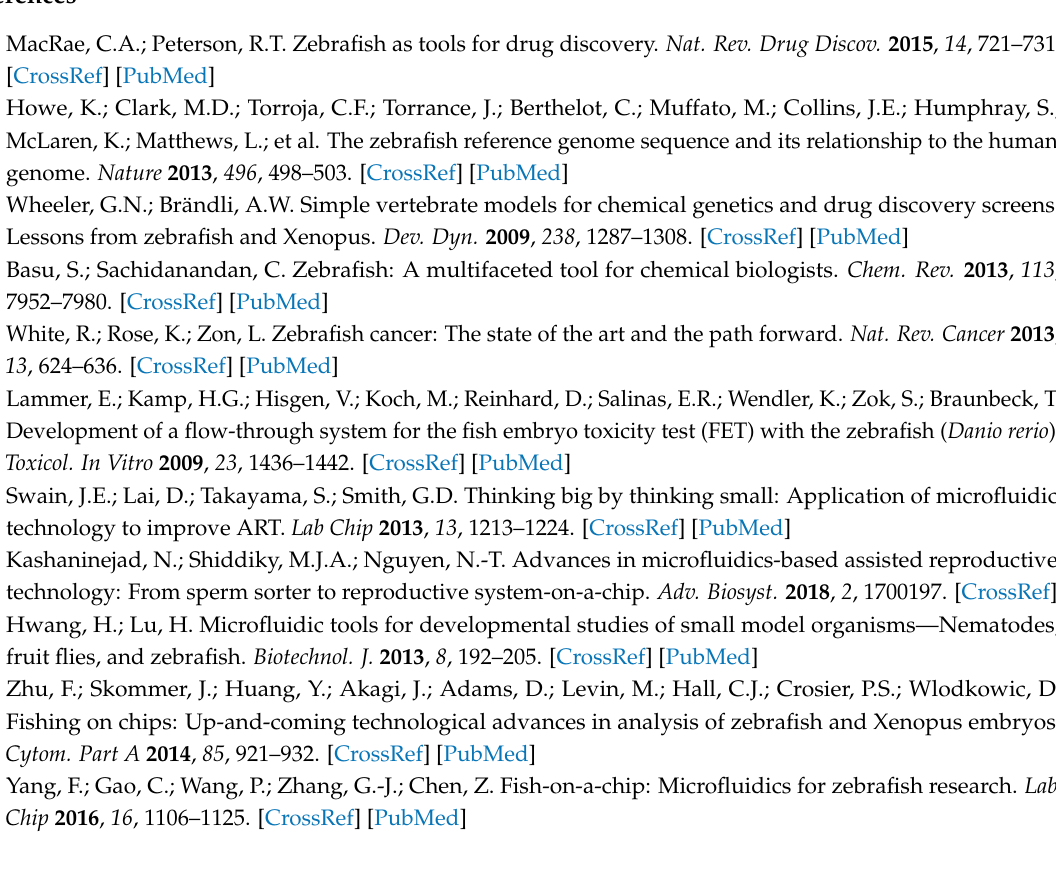
s1, Figure S1: Translucent meshing profiles of the microfluidic structures (A) without and (B) with spheres. Table S1: Element size parameters in meshing of 3D CFD